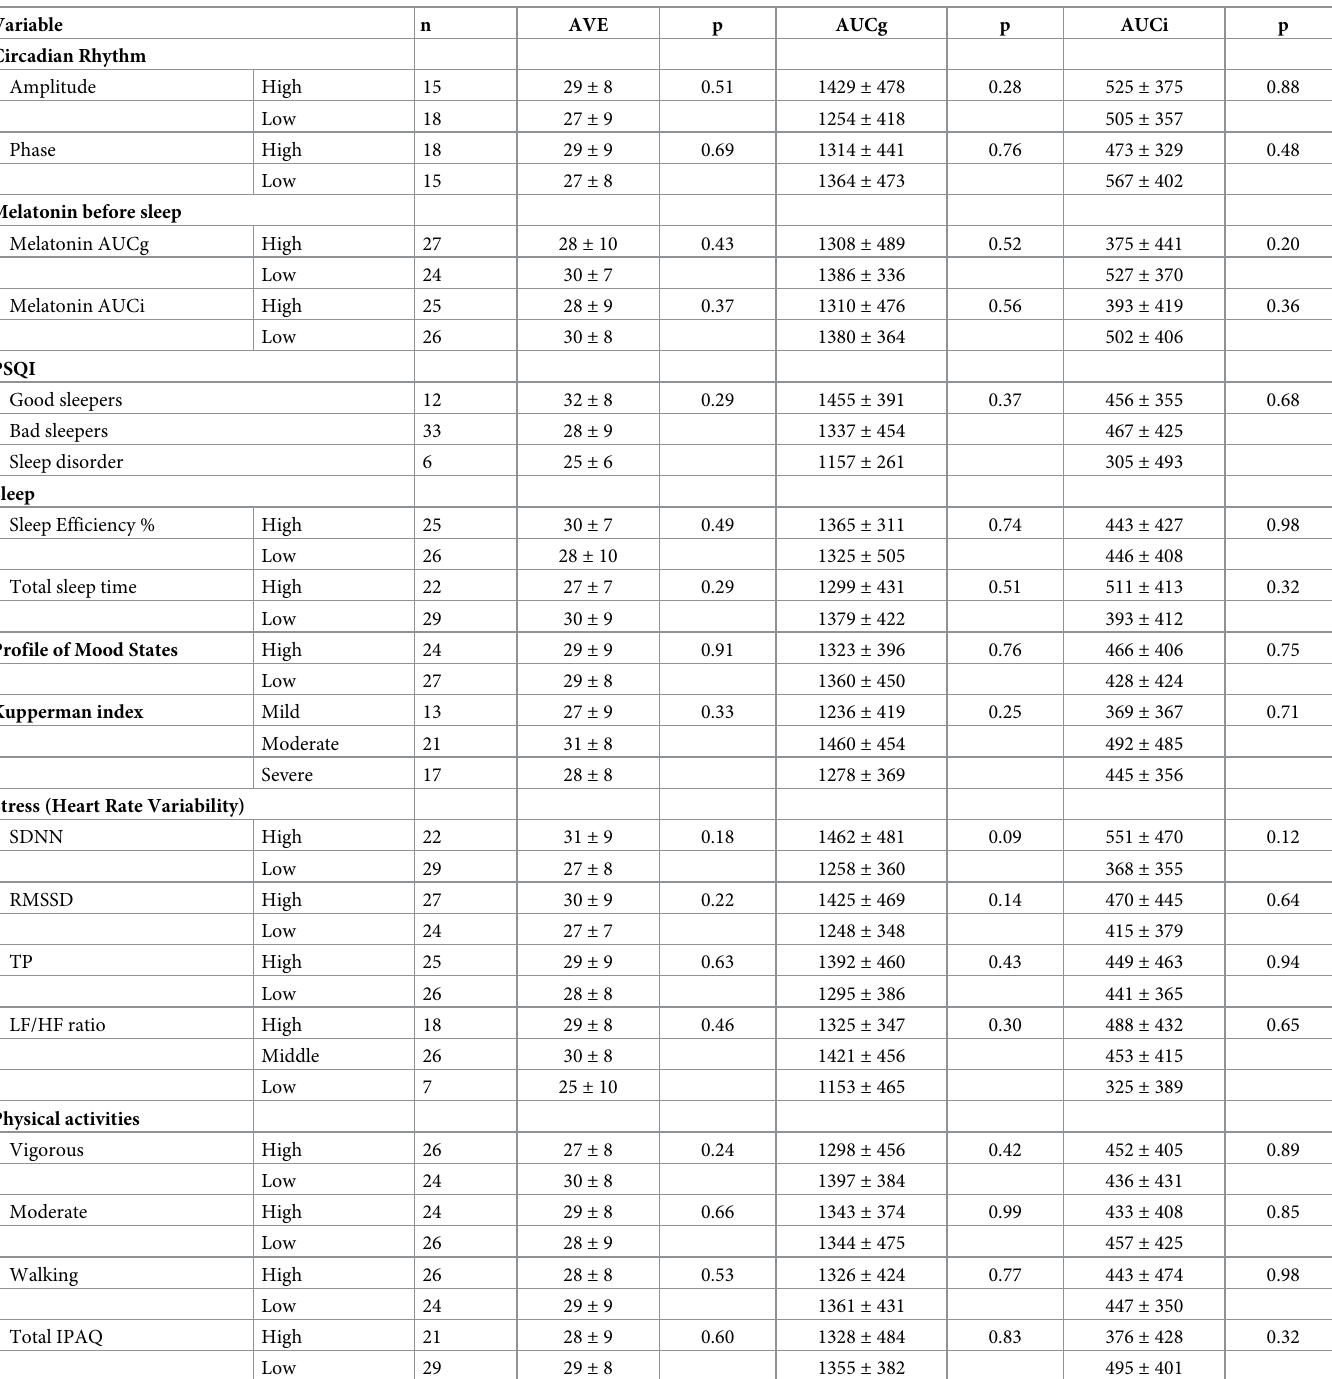
Table 4. Differences in CAR after the program based on multiple variables including circadian rhythms, sleep, stress, and physical activities.